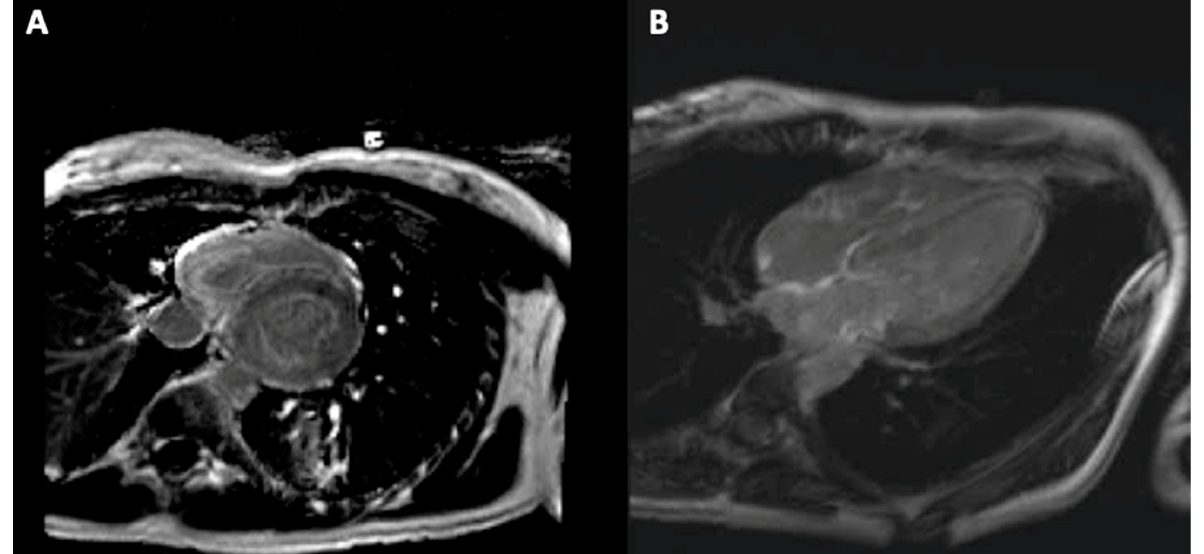
Figure 5. Biventricular subendocardial late gadolinium enhancement ( A ) and atrial late gadolinium enhancement ( B ) in a young patient with cardiac amyloidosis.